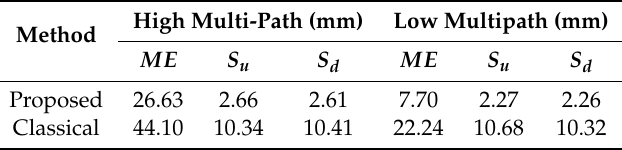
Table 2. Comparison of mean error in differential distance ( ME ) calculated from the proposed and the classical methods and the standard deviation in the static measurement using up-chirp ( S u ) and down-chirp ( S d ).